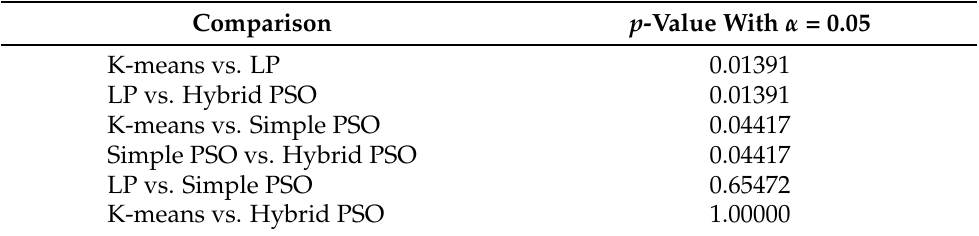
Table 20. The results from the Friedman test: the comparison between each metaheuristic using the arithmetic means of the sums of the distances between the gateways and the IoT devices.